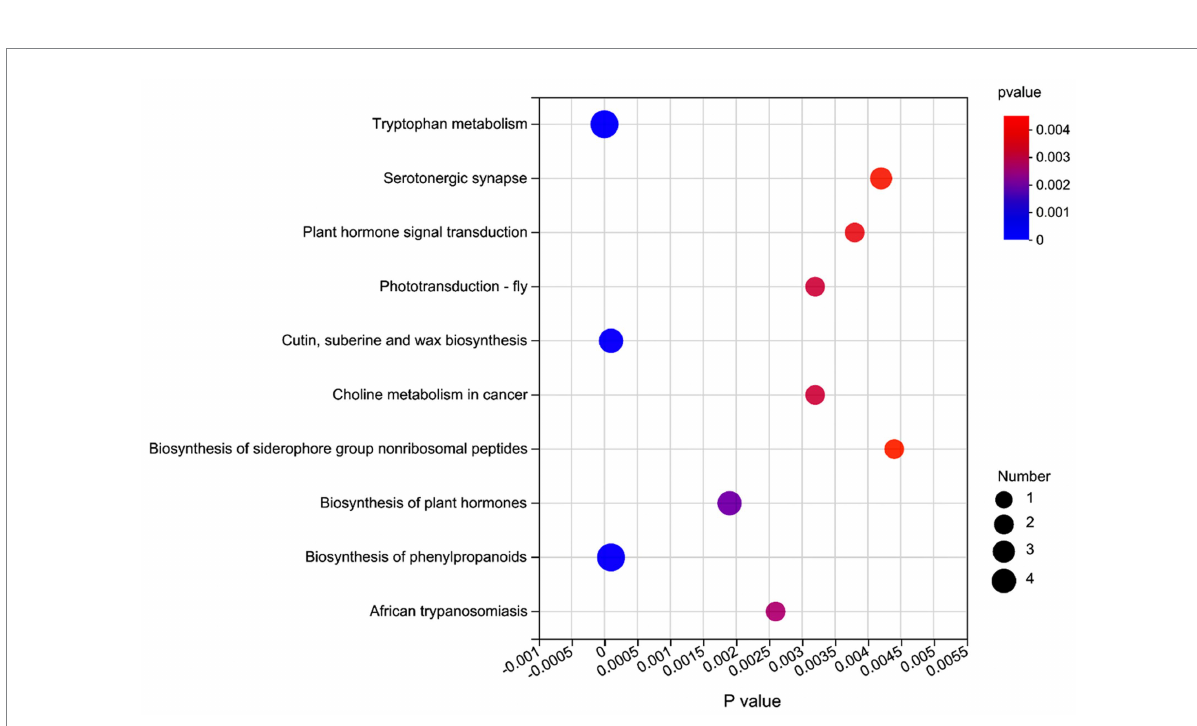
FIGURE 4 Metabolic pathway enrichment analysis of significant differential metabolites in the rumen fluid of dairy cows after 48 h in vitro fermentation with two glucogenic and a lipogenic diet. The color is to distinguish the enrichment significance ( p value), the darker the color, the more significantly the metabolic pathway is enriched. The y axis indicates the name of the KEGG metabolic pathway (top 10). The x axis indicates the p value. A larger size dot indicates a higher pathway